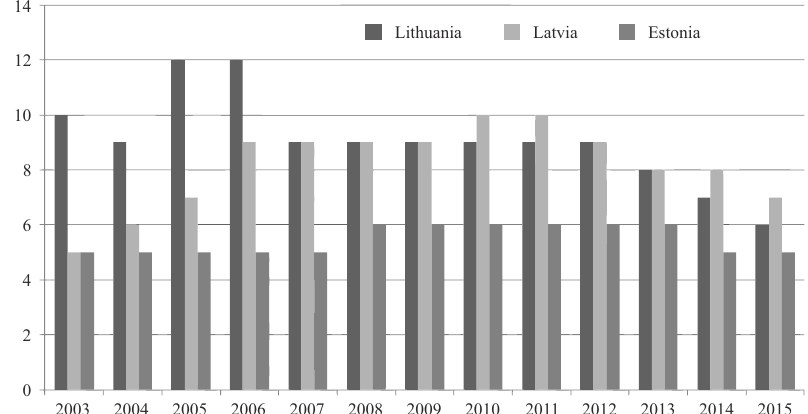
Fig. 1. Number of second pillar pension accumulation companies in Lithuania, Latvia, and Estonia, from establishment until